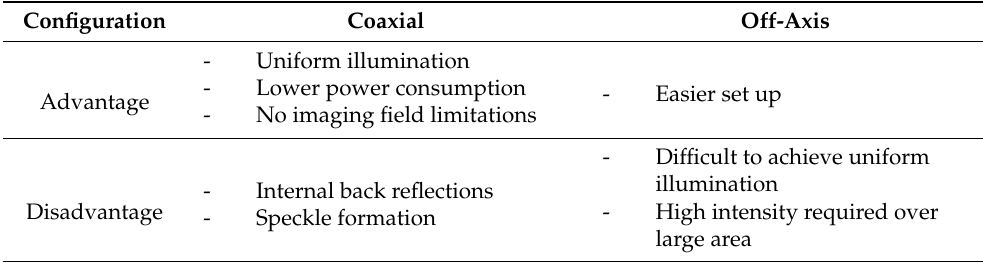
Table 2. Advantages and disadvantages of the different configurations of the external illumina- tion